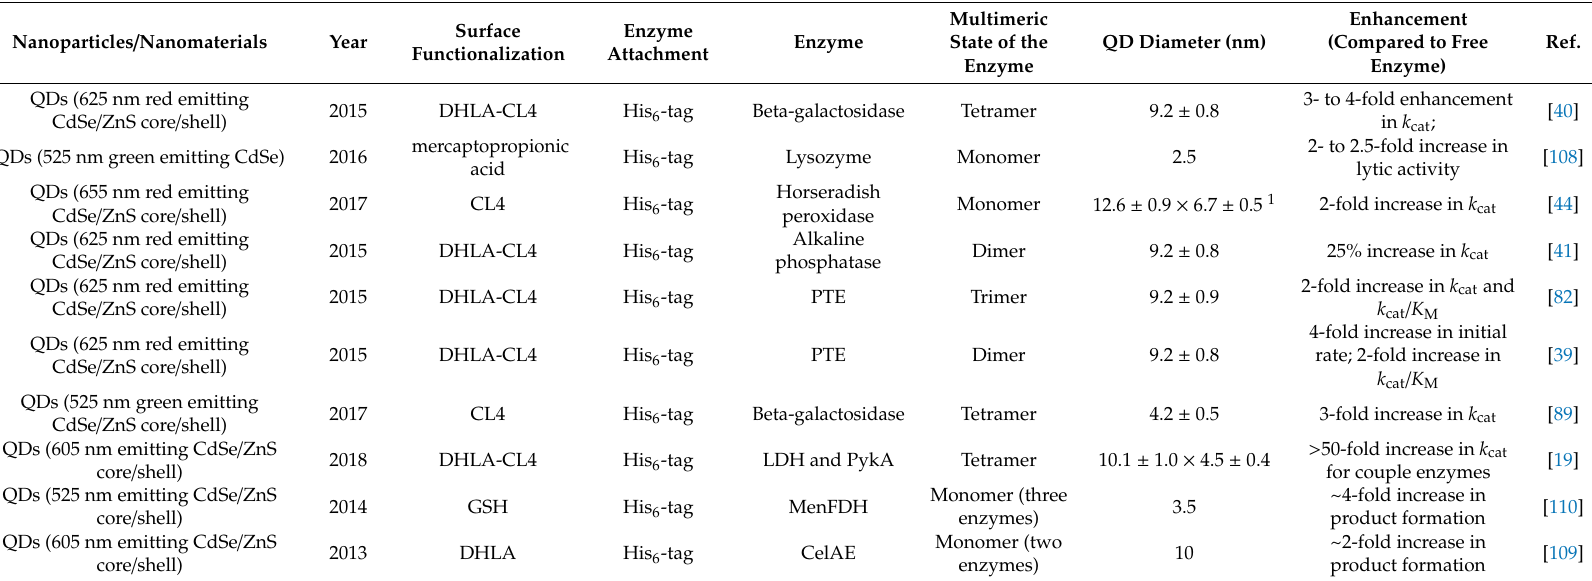
Table 6. Overview of representative QD-immobilized